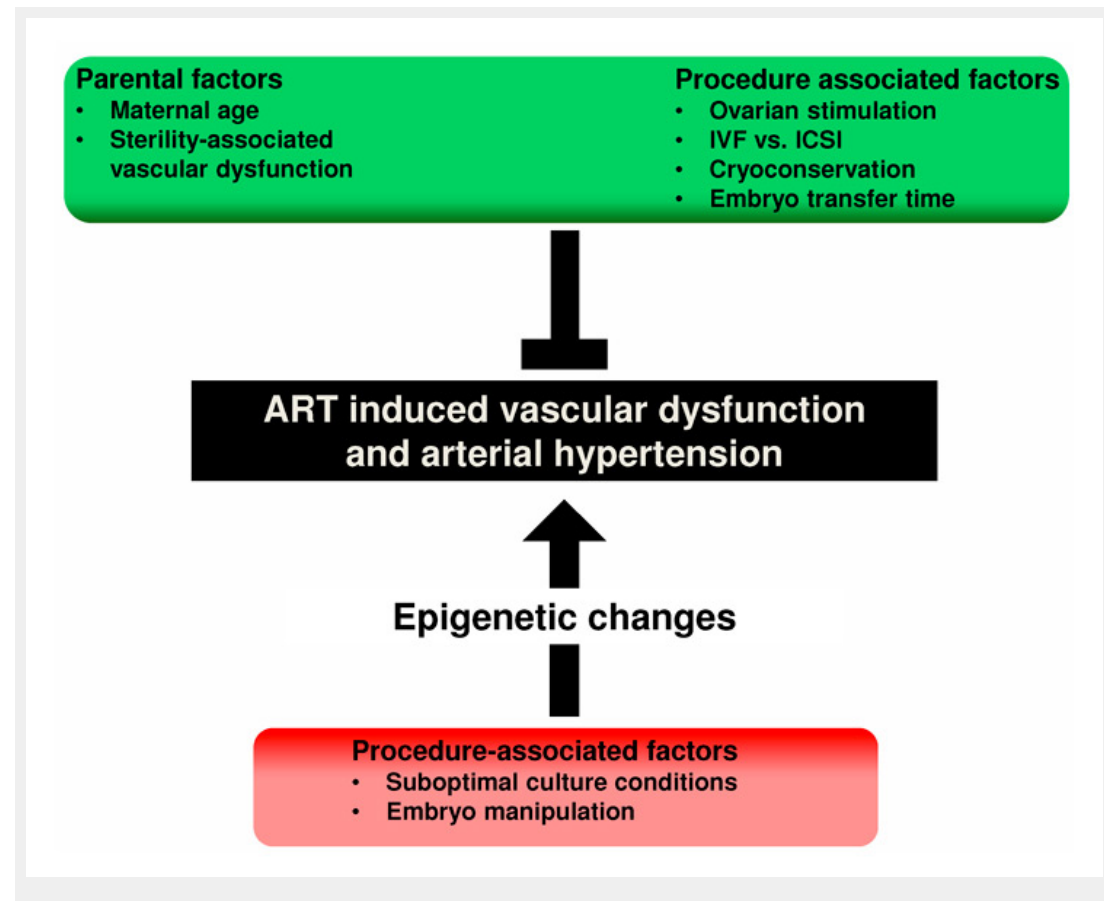
Figure 5 Potential factors involved in the development of ART-induced vascular alterations. Parental and procedure-associated factors that seem not to be major determinants of vascular changes are marked in green, procedure-associated factors that may play a major role in